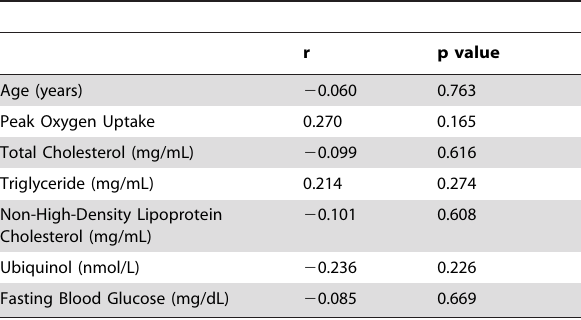
Table 3. Correlations Between Changes in PWV and Other